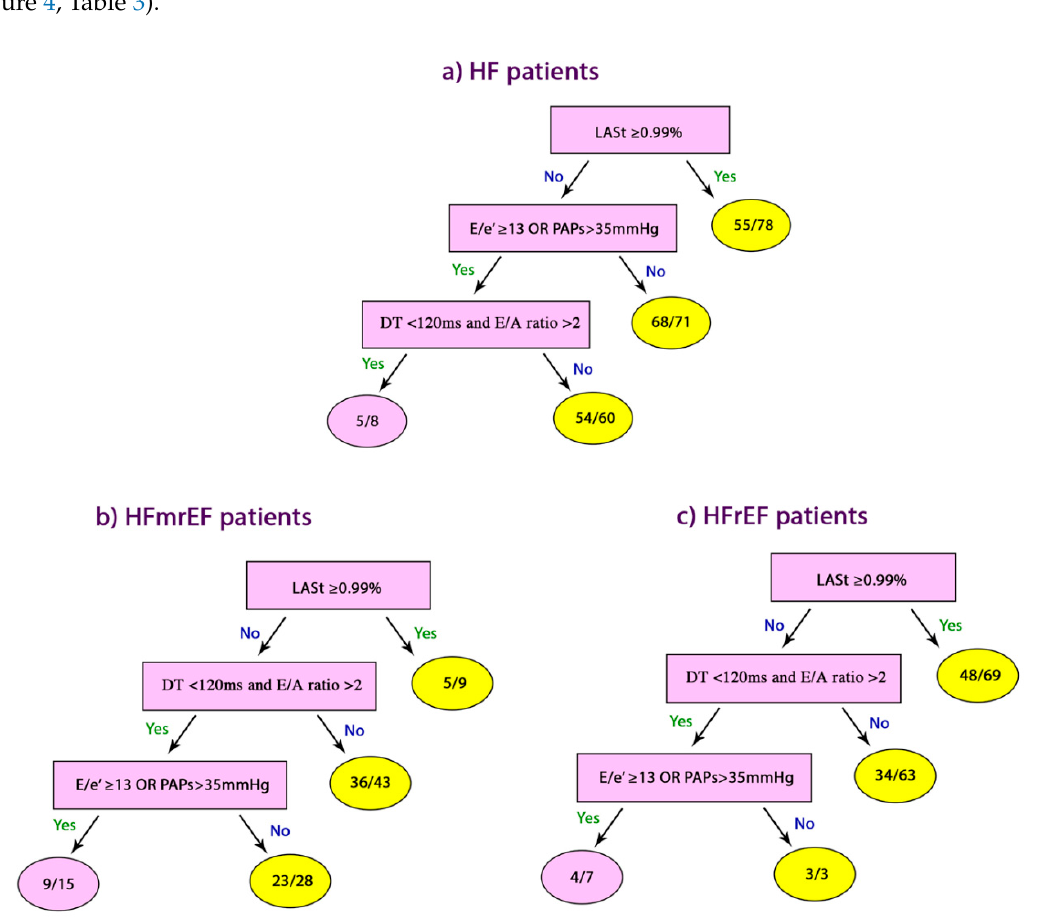
Figure 4. Echo predictors of CE based on CART analysis. ( a ) All HF patients; ( b ) HFmrEF patients; ( c ) HFrEF patients; CE: cardiac events; CART: Classification and Regression Tree Analyses. Table 3. Diagnostic accuracy of echocardiographic parameters in predicting CE in HF patients.